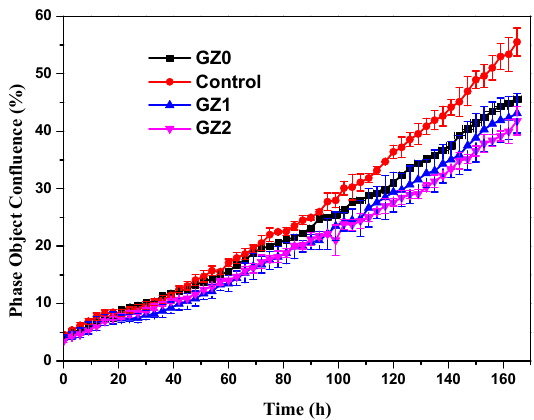
Figure 8. Real-time cell confluence study MRC-5 cells. The cell population was monitored for 168 h using an Incucyte™ Zoom system in an incubator (5% CO 2 and 37 °C).